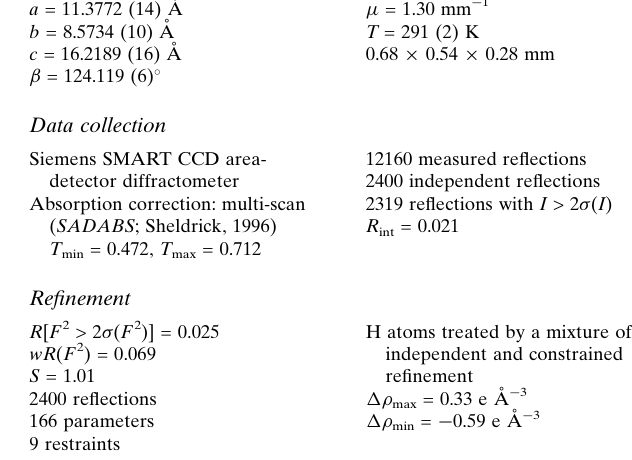
12160 measured reflections 2400 independent reflections 2319 reflections with I > 2 (cid:1) ( I ) R